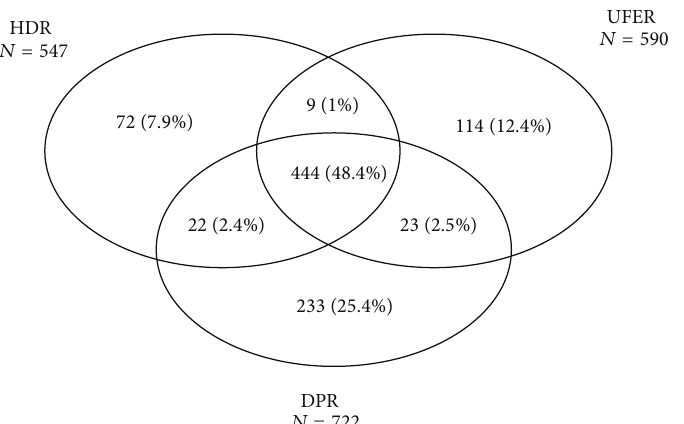
Figure 2: Contribution of HDR, UFER, and DPR to the creation of the total number of patients < 18 years with T1DM (the Unique Database). Apulia, Italy,